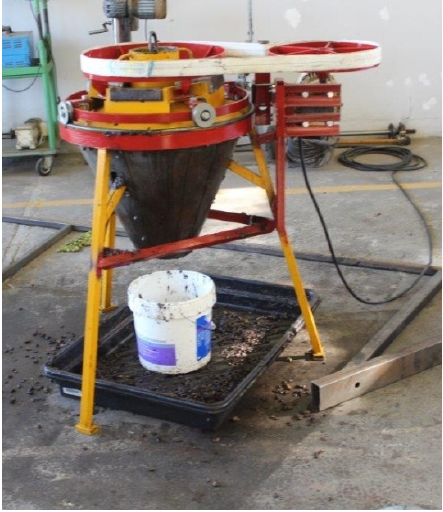
Figure 7. Overview of the working elements of the final prototype.